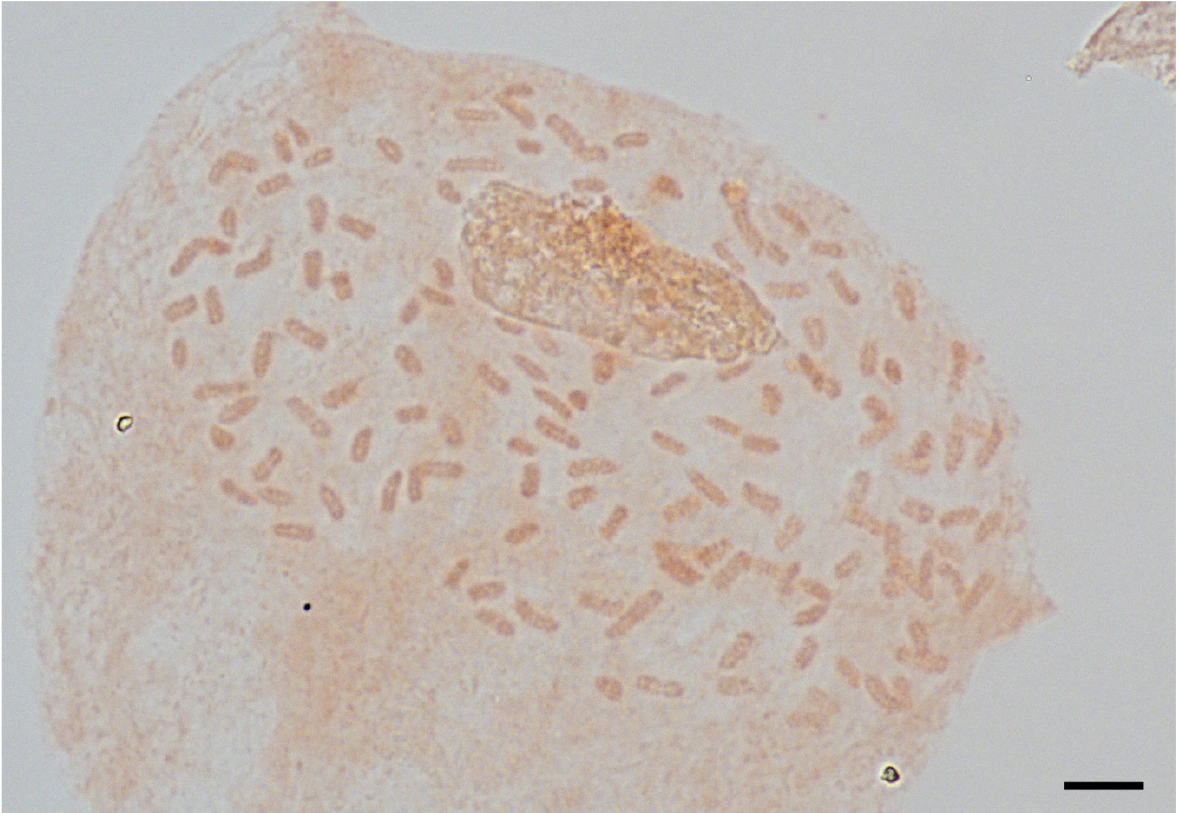
Figure 2. The mitotic chromosomes of Asplenium sp., 2n = 144. Microscopic photo. Scale bar = 10 μ m.